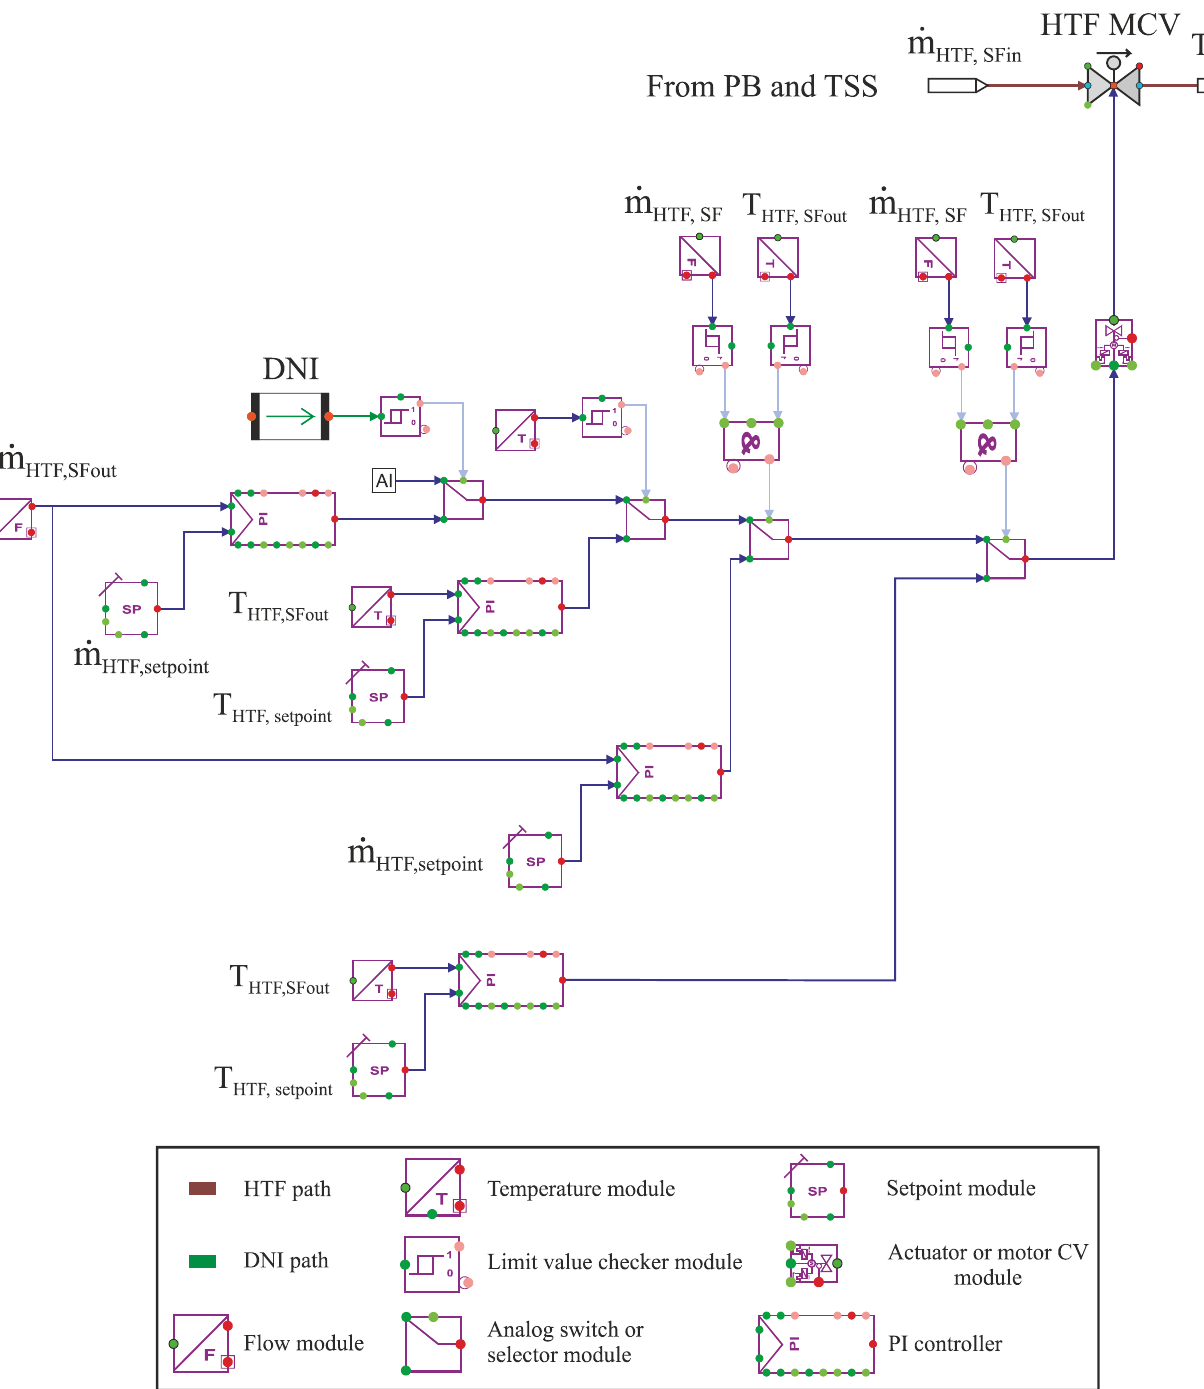
Figure 3. HTF main control valve at the inlet of the SF (simplified).